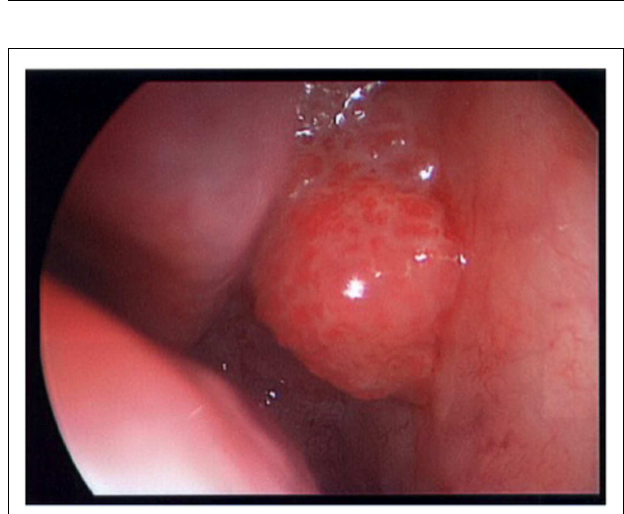
FIGURE 1 | MRI of esthesioneuroblastoma/inverted papilloma collision tumor . Mass can be visualized in addition to inspissated secretions in the surrounding sinuses.